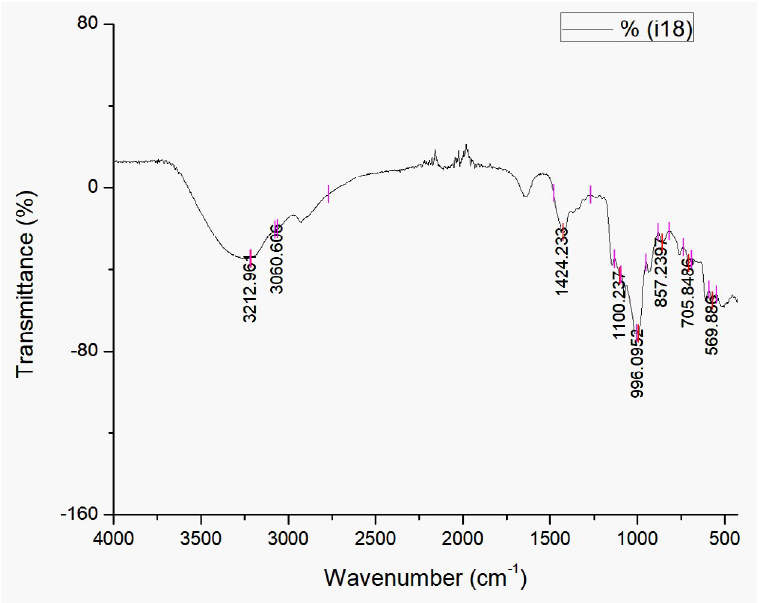
Fig. 3. Infrared spectroscopy using FTIR at biosurfactant produced by Streptomyces hygroscopicus subsp. hygroscopicus strain i18 fermentation